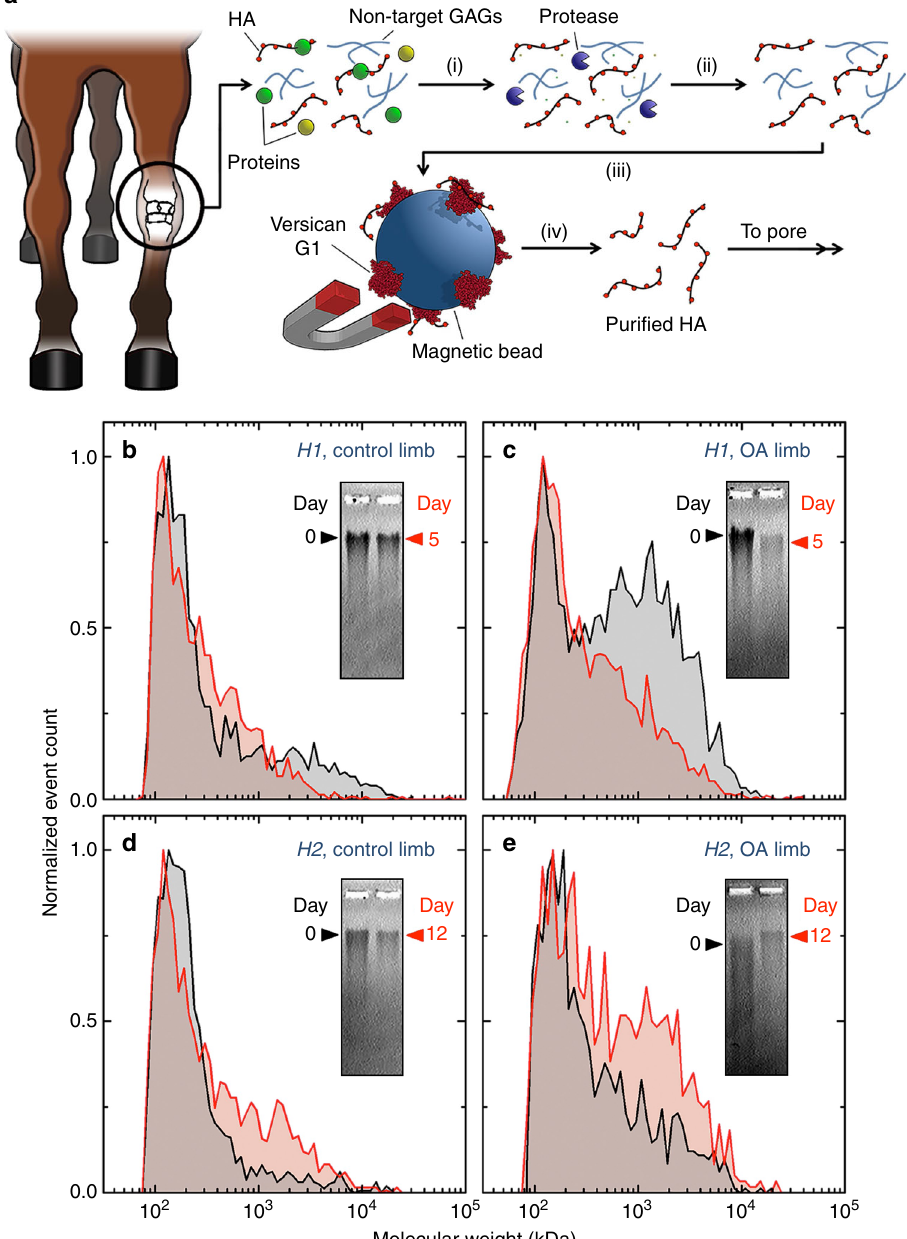
Fig. 4 Translational analysis of HA derived from equine synovial fl uid. a Illustration of HA isolation protocol: (i) collected equine synovial fl uid is treated with a broad-spectrum protease to digest proteins; (ii) liquid – liquid phase extraction is used to remove protease and remnant protein components; (iii) HA is selectively isolated on versican G1 magnetic beads; and (iv) elution yields pure HA for SS-nanopore analysis. b – e Equine synovial fl uid HA size distributions obtained from SS-nanopore ECD analysis. For each, day 0 is black and day 5 or 12 is red. Horse H1 control (sham knee): day 0 ( n = 1768), day 5 ( n = 1680); H1 -induced OA knee: day 0 ( n = 2590), day 5 ( n = 2849); H2 control (sham knee): day 0 ( n = 1748), day 12 ( n = 1692); H2- induced OA knee: day 0 ( n = 1141), day 12 ( n = 1215). Measurements were performed on four different nanopores with diameters ranging from 7.6 to 9.6 nm. Insets show accompanying gel images for the same synovial fl uid samples with band positions